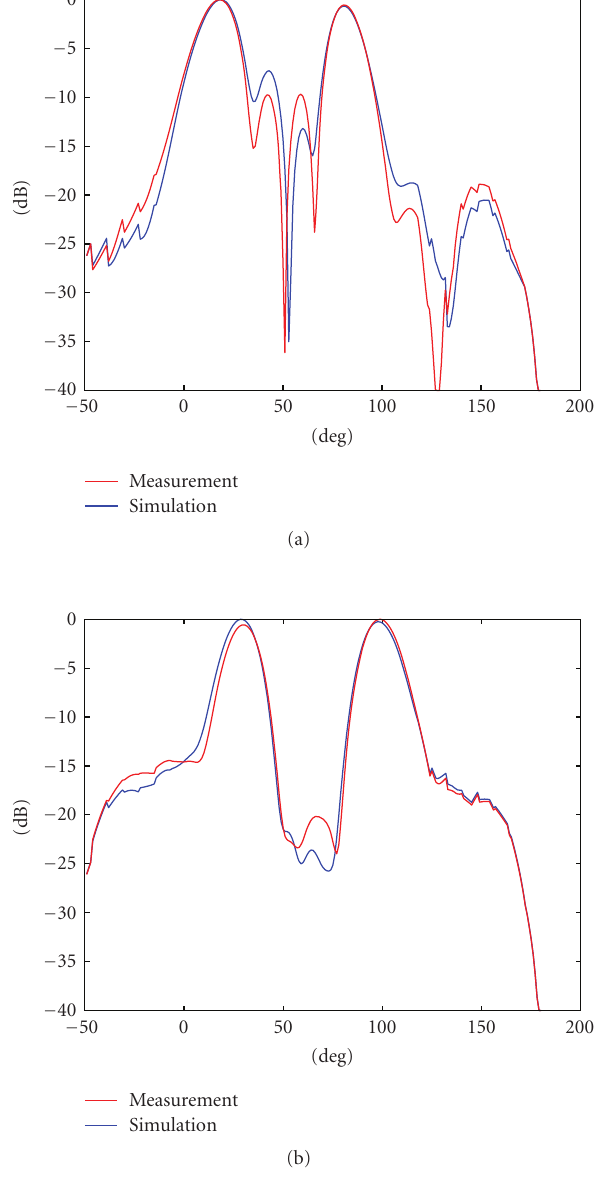
Figure 7: (a) Steering 2 lobes (20 ◦ and 80 ◦ ). (b) Steering 2 lobes (30 ◦ and 100 ◦